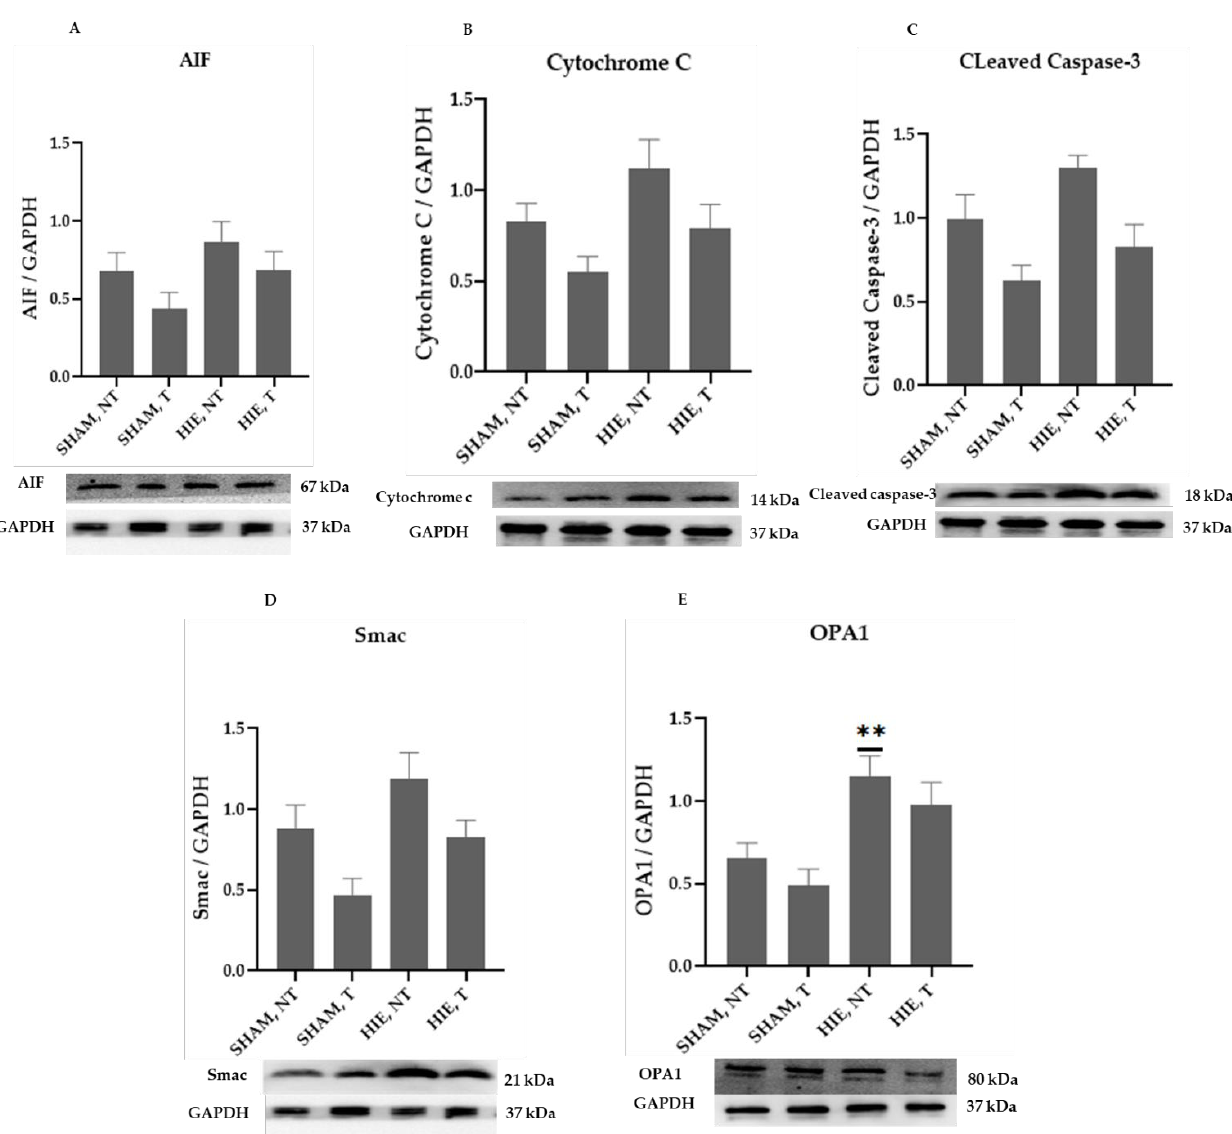
Figure 2. Protein changes in the cytoplasm of the hippocampus. Examples of Western blot bands normalized to GAPDH are presented (with the matching wells). Units are presented relative to GAPDH content. ( A ) AIF, apoptosis-inducing factor, ( B ) cytochrome c, ( C ) cleaved caspase-3, ( D ) Smac/Diablo, and ( E ) OPA1. Asterisks denote statistically significant differences between groups (*, vs. SHAM, NT). One asterisk (*) denotes p < 0.05 (**) denote p < 0.01. F-values after running one-way ANOVAs with Dunnett’s post hoc multiple comparison test were: F = 2.264 (AIF), F = 3.775 (cytochrome c), F = 6.125 (cleaved caspase-3), F = 5.140 (Smac/Diablo) and F = 7.096 (OPA1). HIE, NT denotes animals with hypoxic ischemic encephalopathy that did not undergo exercise training; HIE, T denotes animals with hypoxic ischemic encephalopathy that received exercise training; SHAM, NT denotes normal animals that did not receive exercise training; and SHAM, T denotes normal animals that received exercise training.